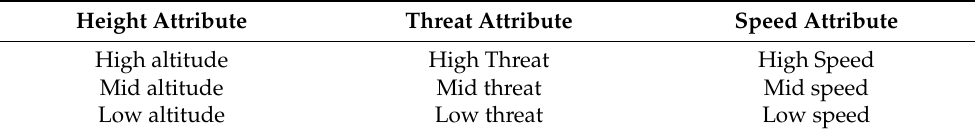
Figure 1. Time pressure experimental process. Table 6. Single attributes possessed by the sample icons.